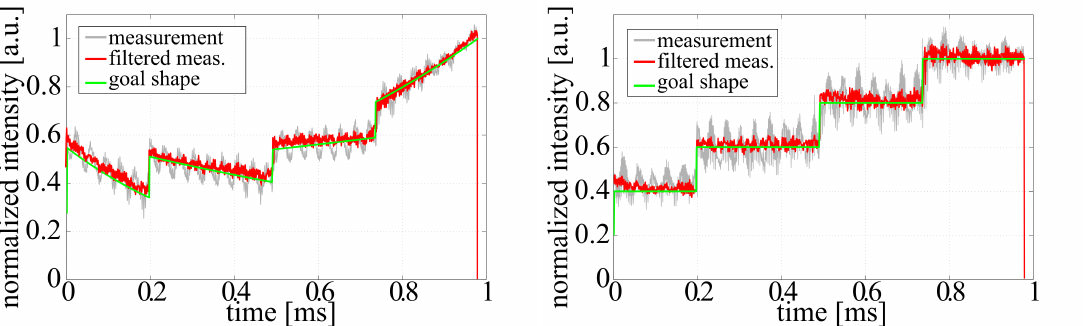
Figure 7. ( Left) : input pulse train shaped to obtain a stair-shaped output; ( right) : resulting output pulse train after